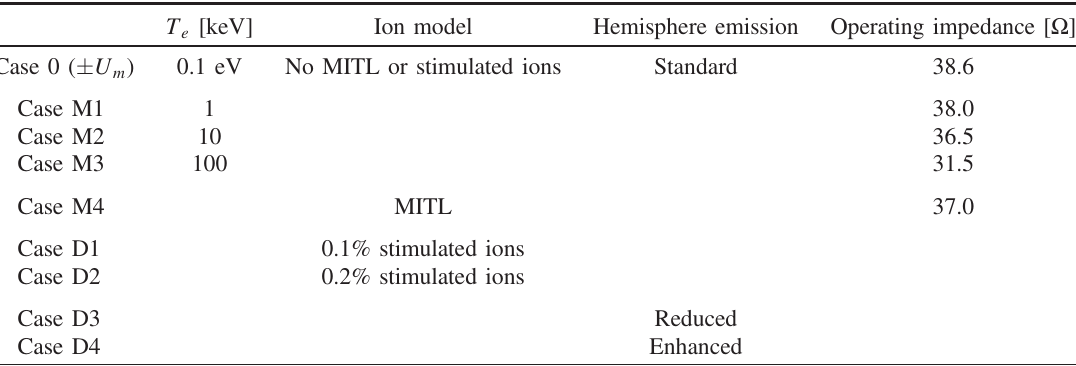
TABLE III. Summary of PIC simulations performed, and the various emission model parameters that were used. Blank entries in the table imply Case 0 parameter